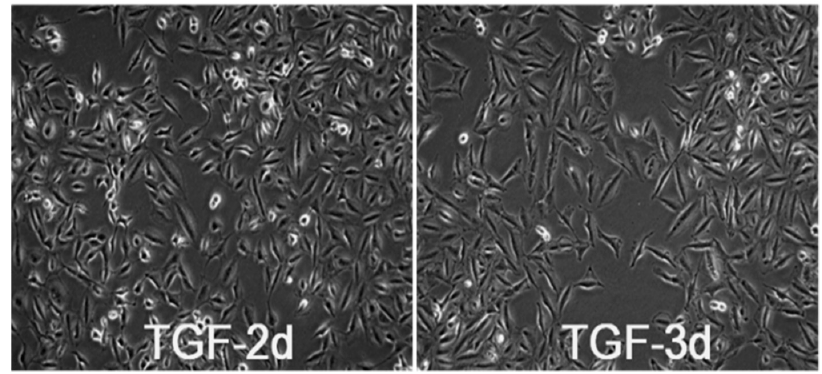
Figure 1. TGF- β induces morphological alteration in A549 cells. A549 cells were exposed to 5 ng/mL TGF- β for 0, 1, 2, 3 days, and morphological features were separately taken at the last day (400× magnification).